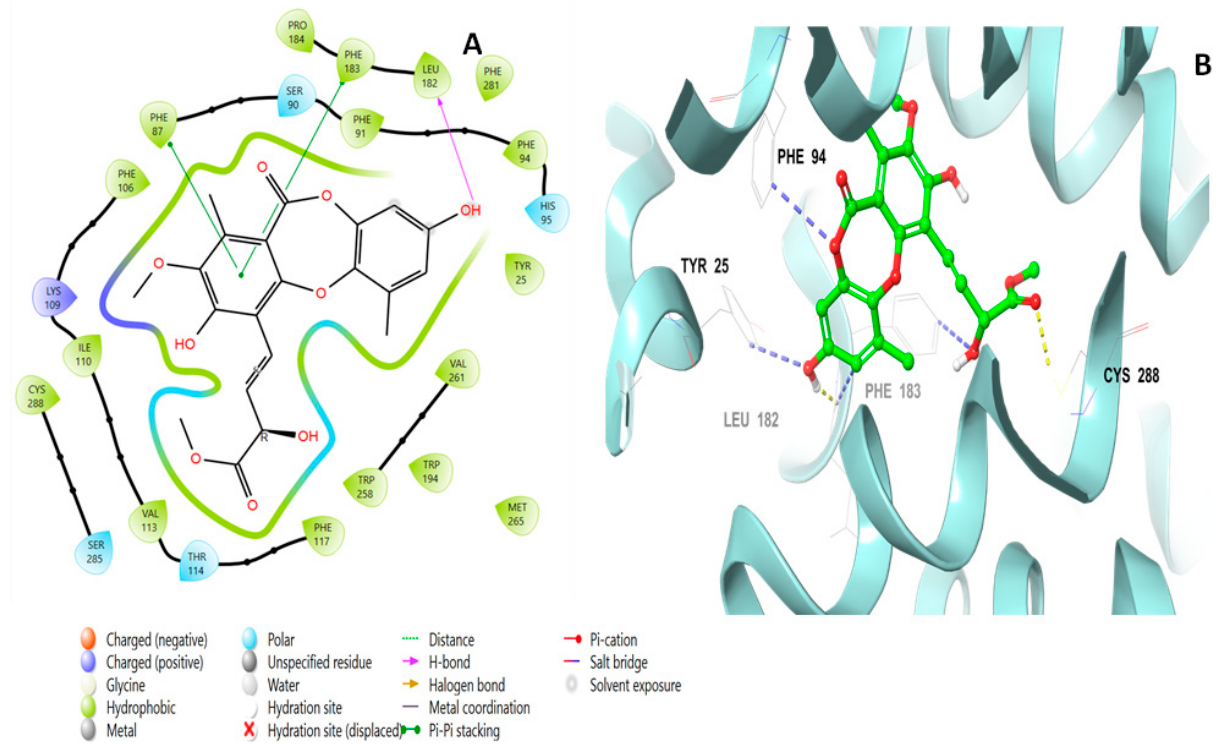
Figure 9. Putative binding mode of boremexin C ( 161 ) at the binding site of CB2 receptor (PDB-ID: 6KPF). Boremexin C ( 161 ) is displayed as green sticks. H bonds are displayed as yellow dotted lines, and ionic bonds as blue dotted lines. ( A ) Two-dimensional view; ( B ) three-dimensional view of CB2 complexed with boremexin C ( 161 ).